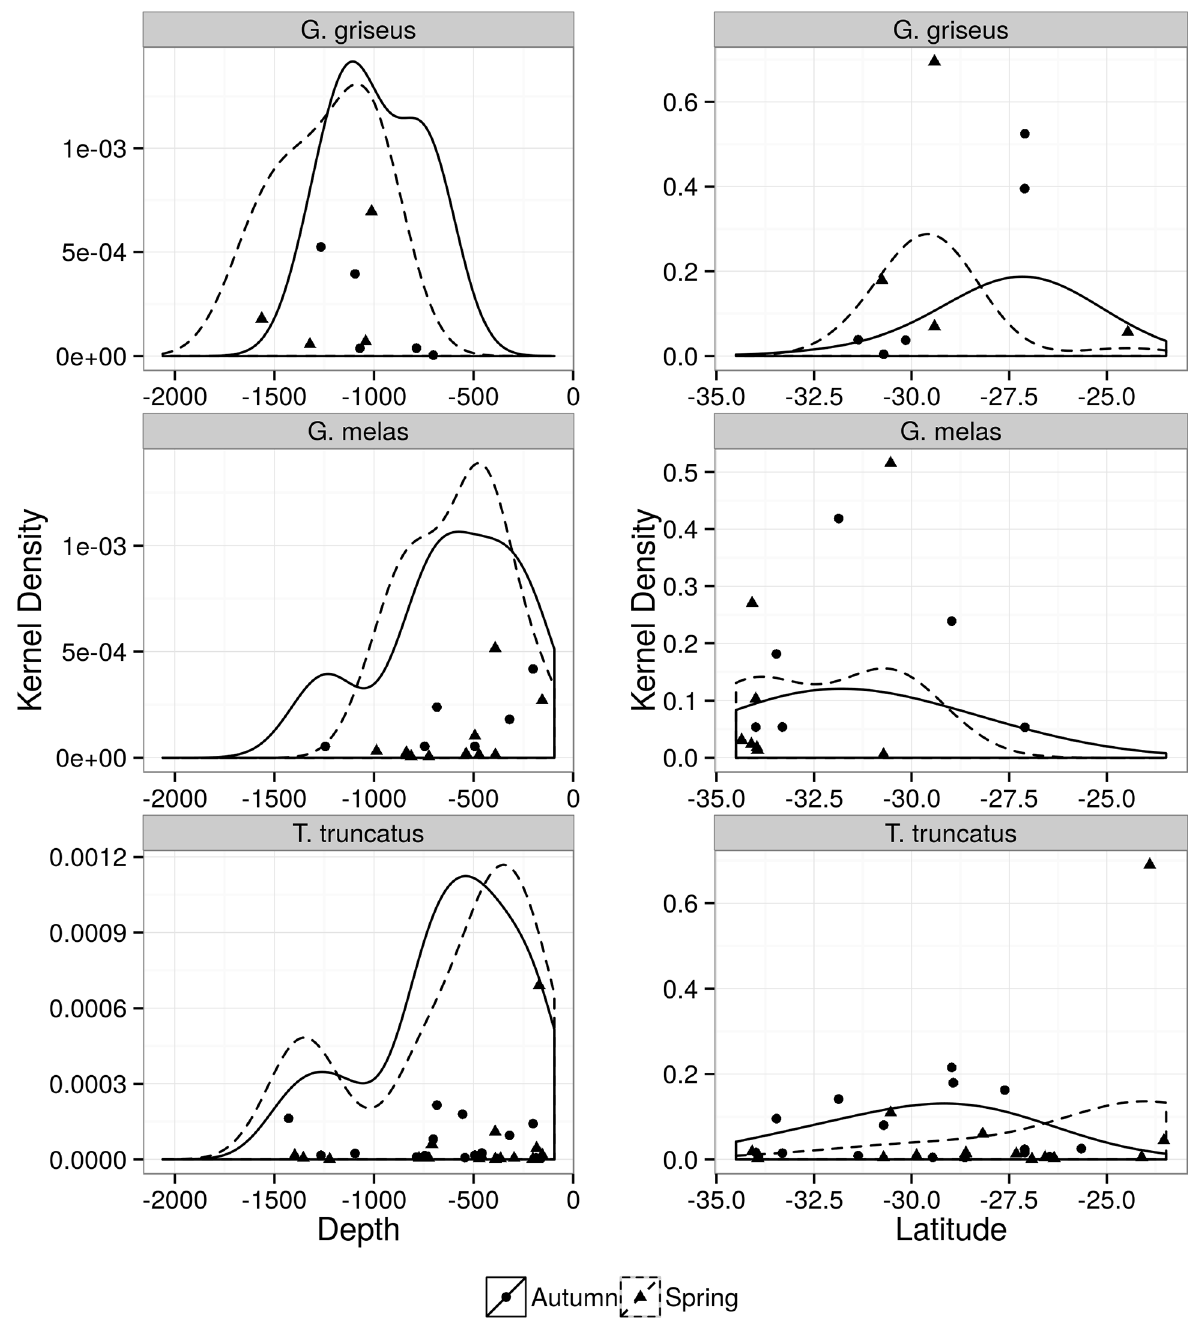
Fig 6. Kernel density distribution of Bottlenose dolphin ( Tursiops truncatus ), long-finned pilot whale ( Globicephala melas ), Risso ’ s dolphin ( Grampus griseus ). Plots are according to depth (left) and latitude (right) during spring (dashed lines) and autumn (solid black lines)